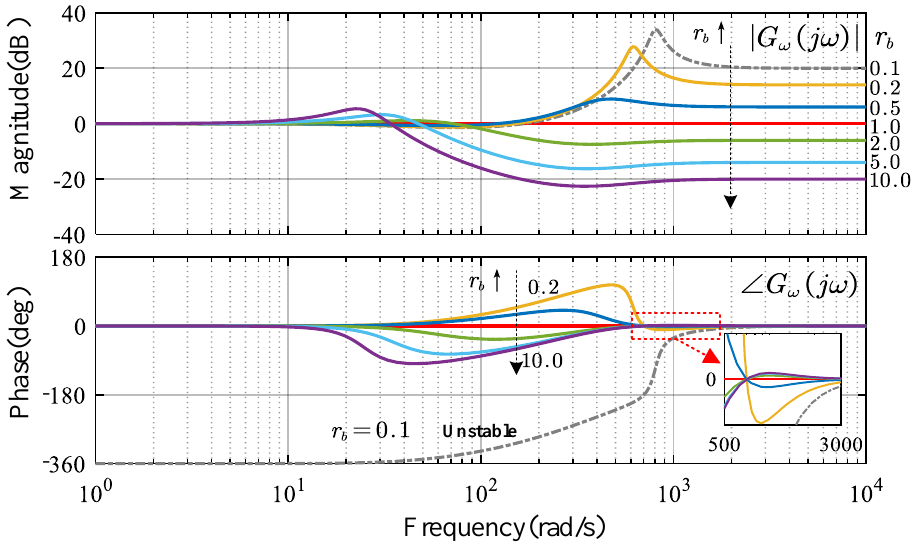
  G s under different 